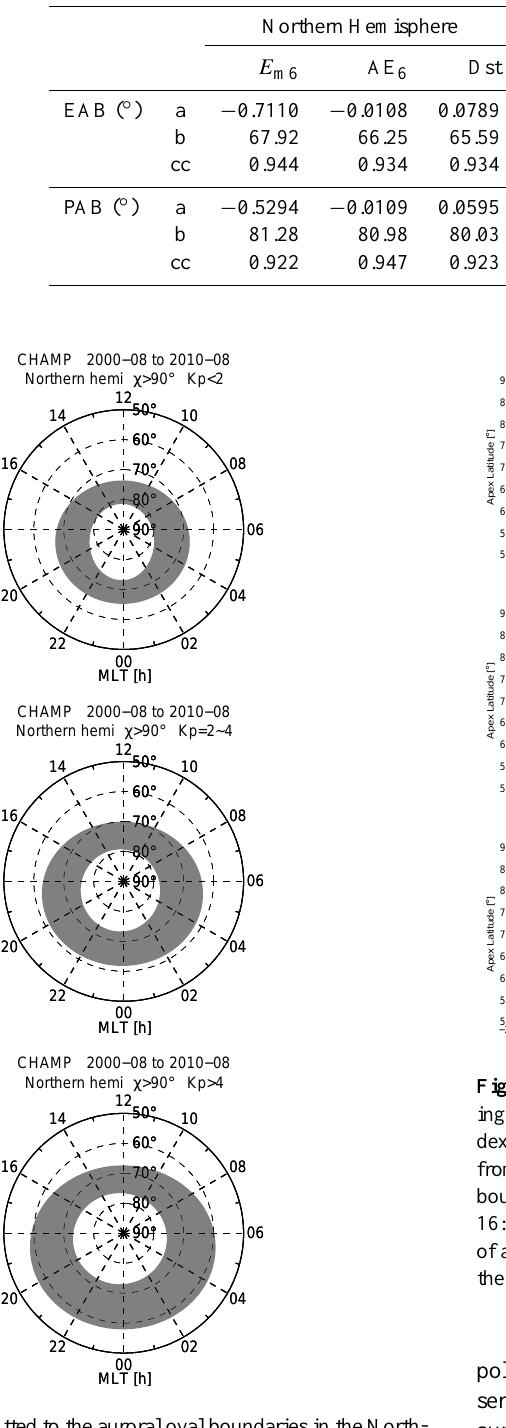
Figure 7. Ellipses fitted to the auroral oval boundaries in the North- ern Hemisphere during quiet (top), moderate (middle), and dis- Fig. 7. Ellipses fitted to the auroral oval boundaries in the northern hemisphere during quiet (top), moderate turbed (bottom) magnetic activities. (middle) and disturbed (bottom) magnetic activities 24